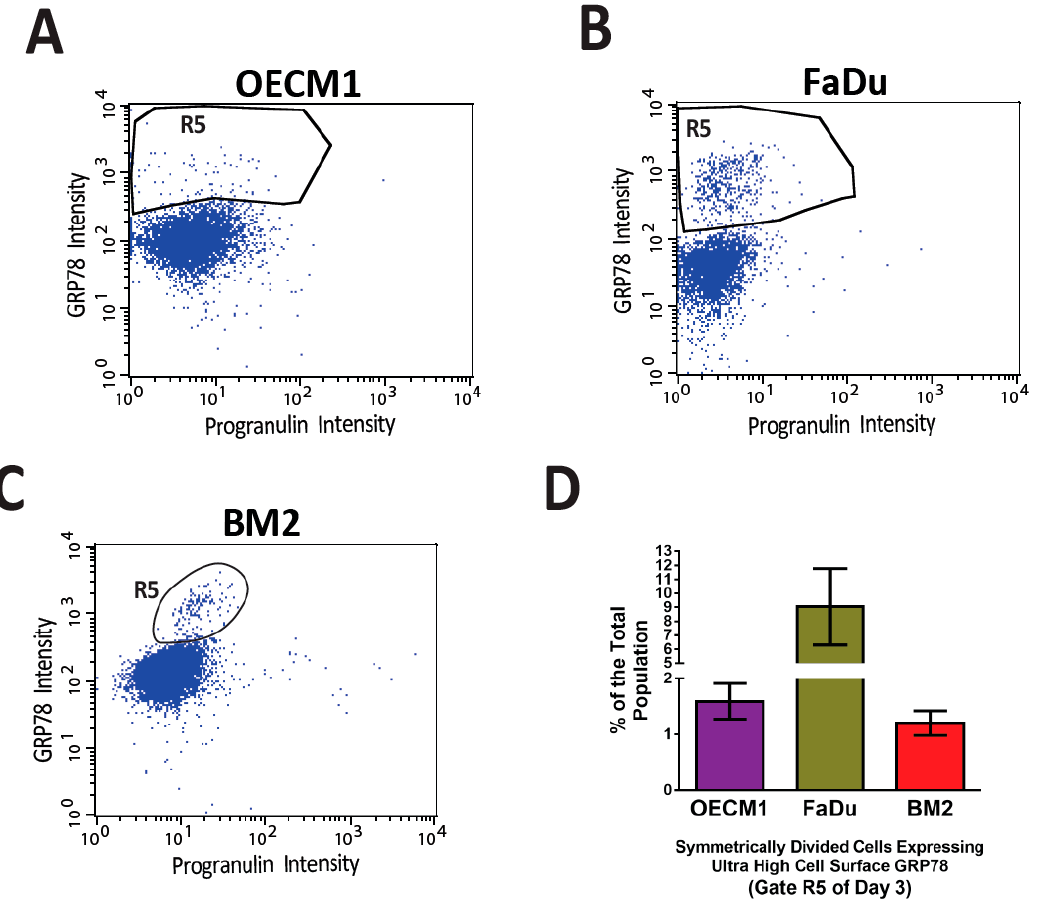
Figure 3. Distinct small populations of symmetrically divided cancer cells expressing ultra-high levels of cell surface GRP78 were consistently observed in the flow cytometry-based cell division assay. In a previously published article by Chen et al. [7], a high throughput flow cytometry-based cell division assay was developed to characterize the profile of asymmetric/symmetric cell divisions in the heterogeneous cell populations of three head and neck cancer cell lines, OECM1 ( A ), FaDu ( B ), and BM2 ( C ). In the three cancer cell lines that went through symmetric cell division (Gate R3 of Figure 5B,D,F of reference [7]), distinct cell populations expressed ultra-high levels of cell surface GRP78 (the R5 gates) consistently above the levels of major csGRP78 positive populations. ( D ) The quantification of the R5 gates of the three head and neck cancer cell lines. The percentages of R5 gates are 1–9% of the total cell populations.